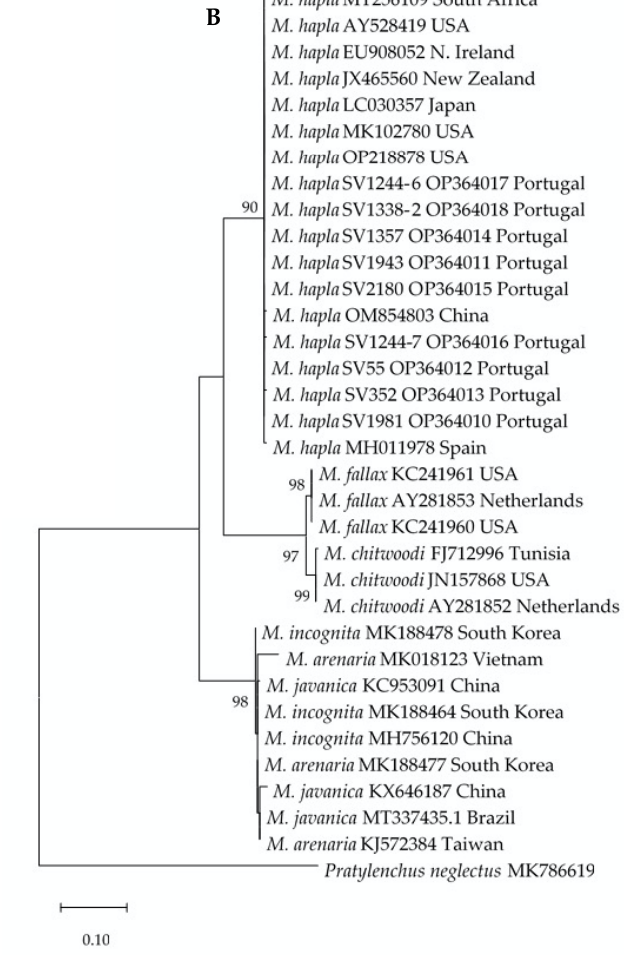
Figure 6. Phylogenetic relationships of Meloidogyne hapla isolates collected from Portugal, and M. hapla isolates from other geographical regions, including other species of the Meloidogyne group, based on the sequence alignment of the ITS region. The dendrogram was inferred by using the maximum likelihood method and the Kimura 2-parameter model. ( A ) This analysis involved 19 nucleotide sequences and there was a total of 261 positions in the final dataset. ( B ) This analysis involved 34 nucleotide sequences and there was a total of 261 positions in the final dataset. Evolutionary analyses were conducted in MEGA 11.